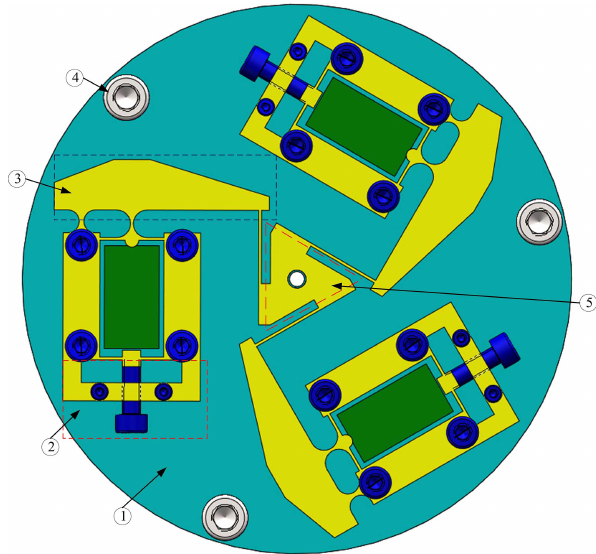
Figure 7. The whole assembled diagram of this three-DOF mi- crostage: (1) The base platform; (2) The pre-tightening mechanism; (3) The lever amplifier; (4) The grounding bolt; (5) The central mo- tion platform.